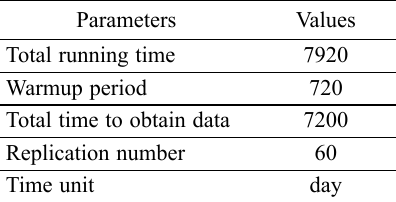
Table 3. Simulation